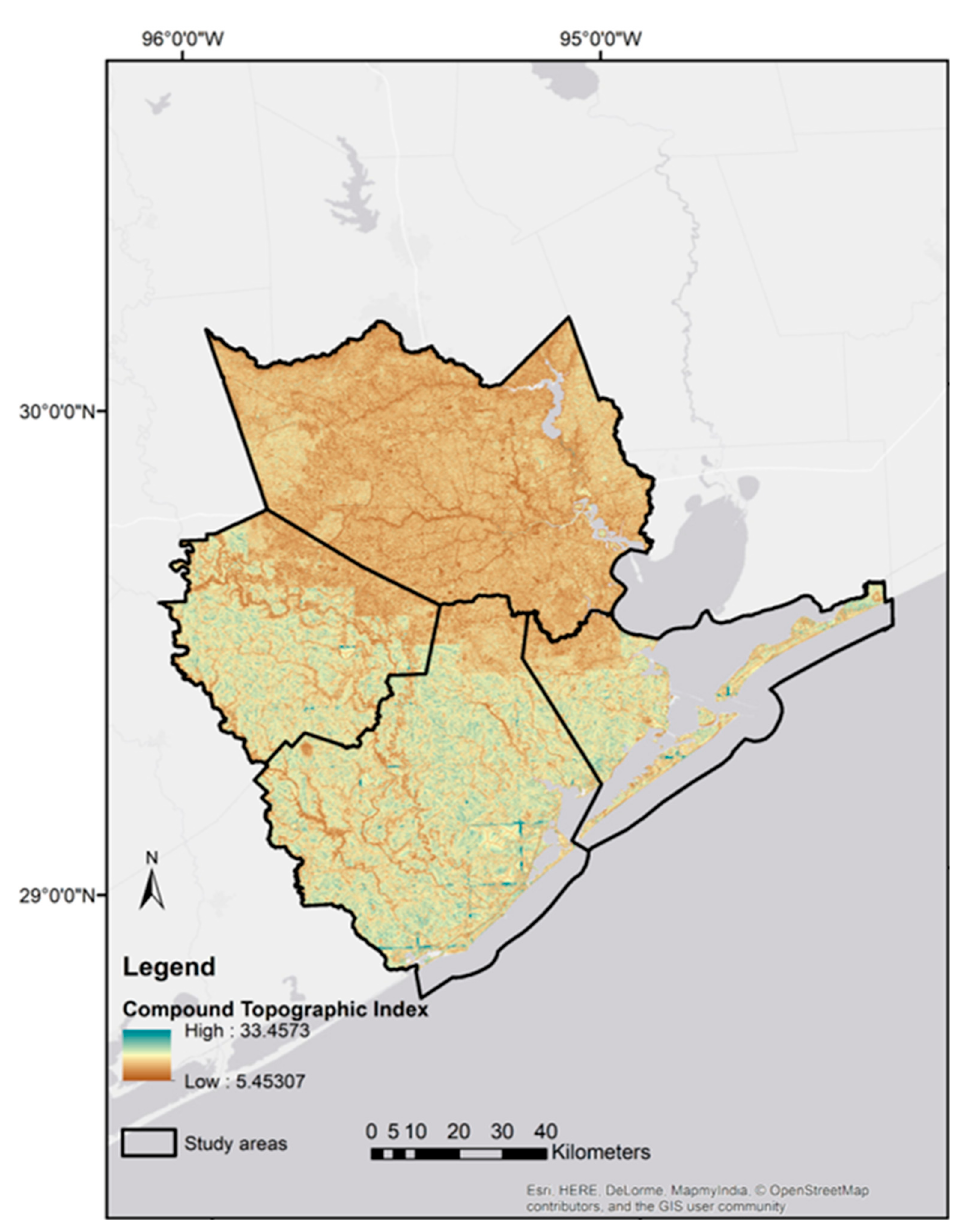
Figure A2 . The distribution of Compound Topographic Index (CTI) across the study area Figure A2. The distribution of Compound Topographic Index (CTI) across the study